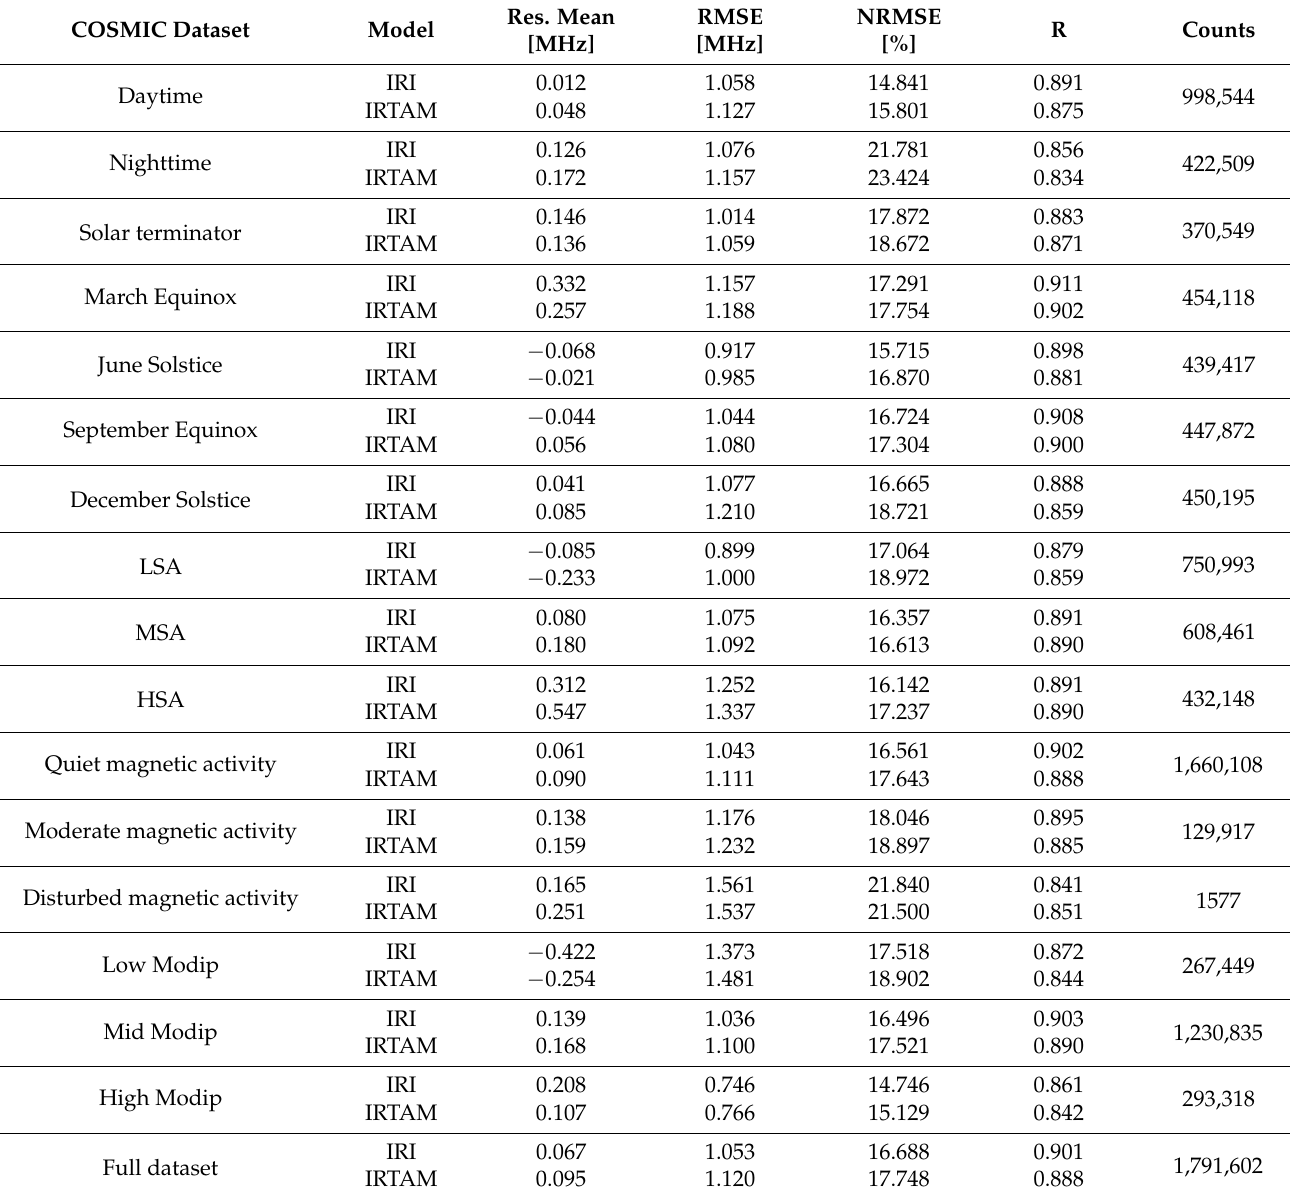
Table 4. Res. Mean, RMSE , NRMSE , and R values calculated for the IRI and IRTAM models on the basis of the fo F2 COSMIC observations, for the bins defined in Section 4.2, according to the three levels of solar activity defined in Section 3.1, and for the full dataset (bottom row). The number of counts on which the statistics were calculated is reported in the rightmost